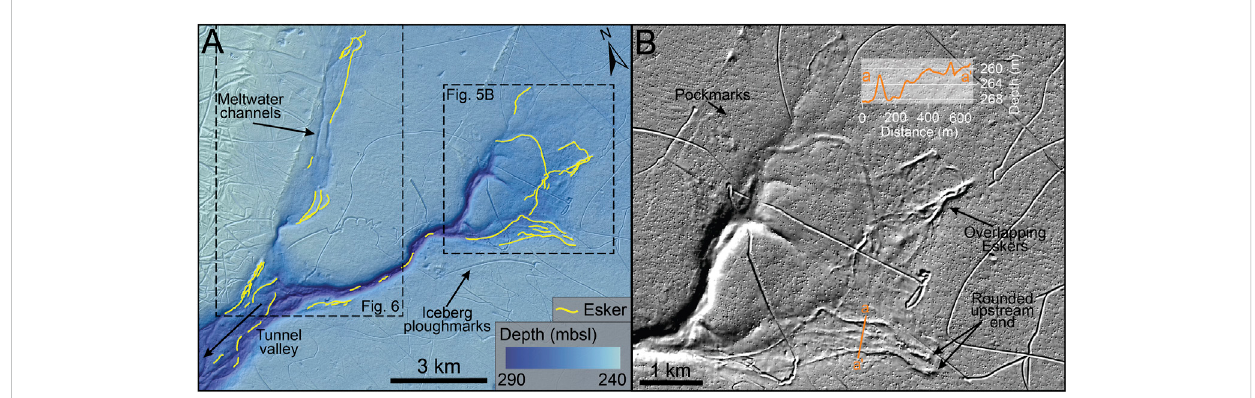
FIGURE 5 Site3: (A) Singularandmultipleoverlappingeskerridgesonarelativelysmoothsectorofthesea fl oorupstreamofthetunnelvalley.Themulti-ridged esker to the southwest of the site was identi fi ed by Bjarnadóttir et al. (2017). (B) Hillshade map and cross pro fi le (a-a ’ ) of eskers, highlighting the rounded upstream ends of some features.